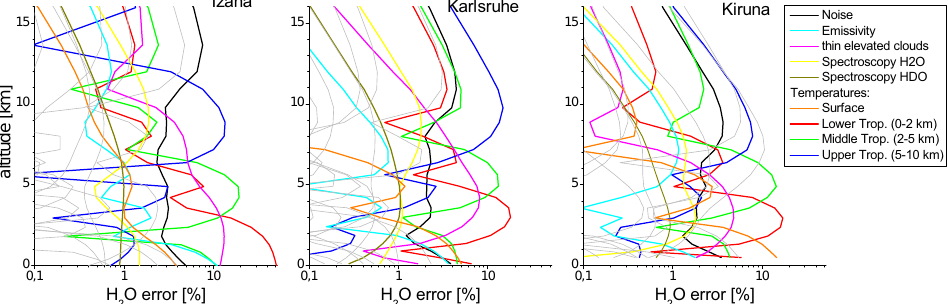
Figure 3. Error estimation for water vapour (product type 1) at all measurement sites. The assumed uncertainty sources are detailed in Table 2. Minor error sources are depicted as grey lines. Table 2. Uncertainty sources and expected magnitudes used for er- ror estimation of the IASI